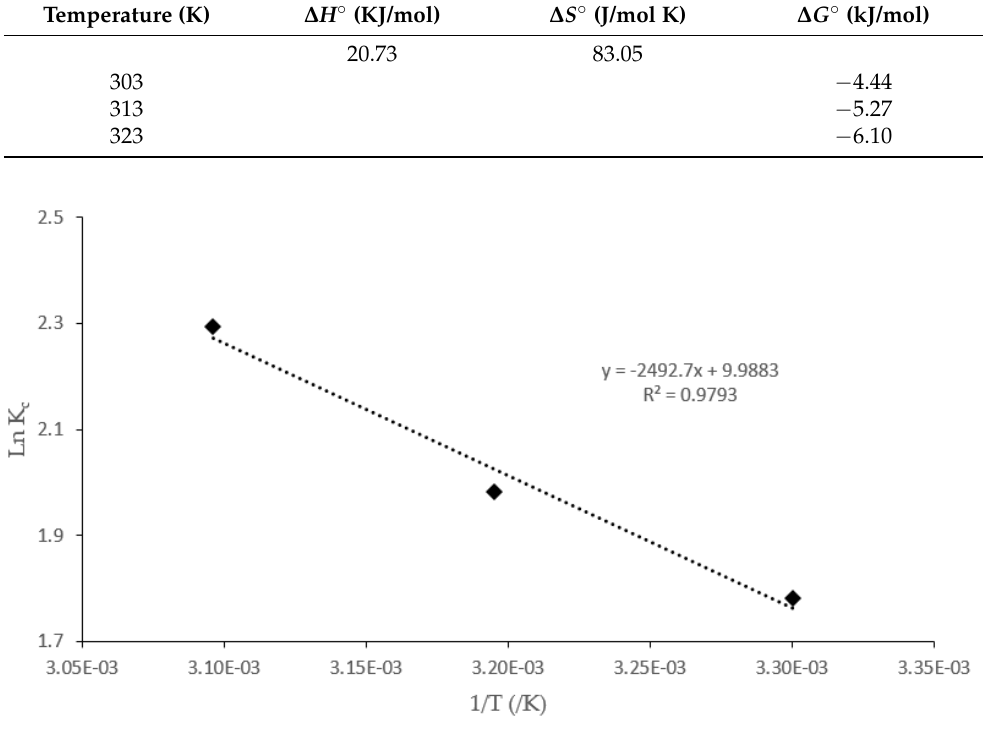
Figure 12. Here, ln K c as a function of reciprocal adsorption temperatures. Table 5. Fluoride adsorption thermodynamic parameters.